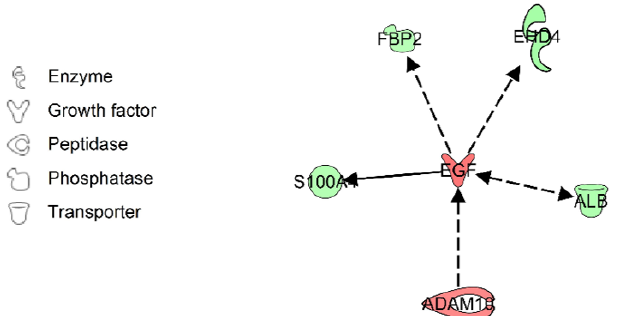
Figure 3. The candidate proteins were those overlapping with differentially expressed proteins in sSS ‐ DED patients versus non ‐ SS ‐ DED and pSS ‐ DED, respectively. Twenty ‐ nine proteins (14 up ‐ regulated and 15 downregulated) were identified.